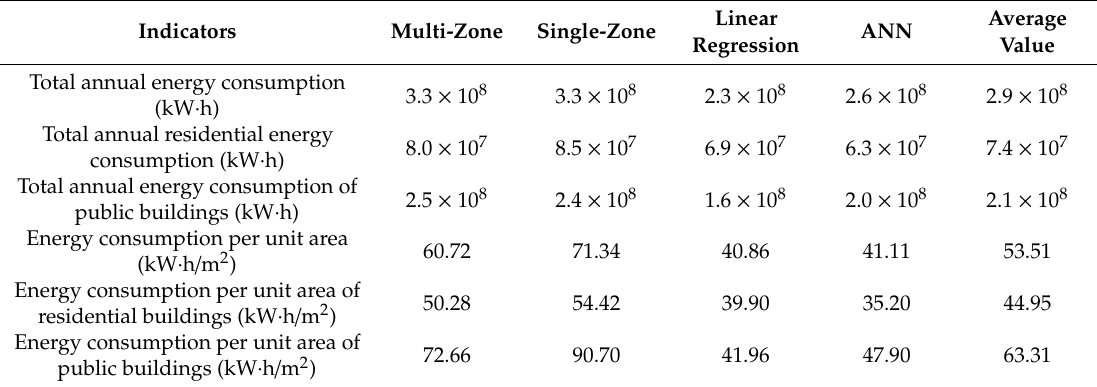
Table 5. The indicators of energy